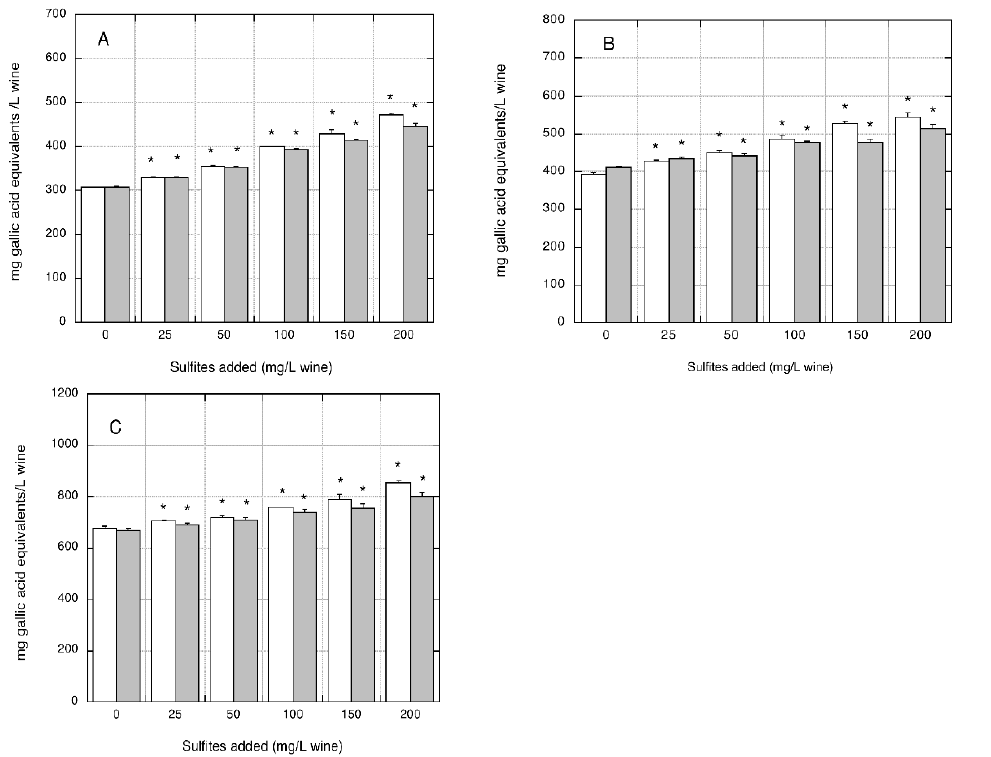
Figure 3 . Effect of sulfite/metabisulfite addition to organic white wines on polyphenols measurements. FC assay was performed using gallic acid for the calibration curve. ( A ) AO organic wine; ( B ) BO organic wine. ( C ) CO organic wine. Closed grey bars: sodium sulfite addition. Open white bars: sodium metabisulfite addition. Data are means of four replicates ± SE. * p < 0.05 relative to control wine without sulfite/metabisulfite addition by Student t -test.